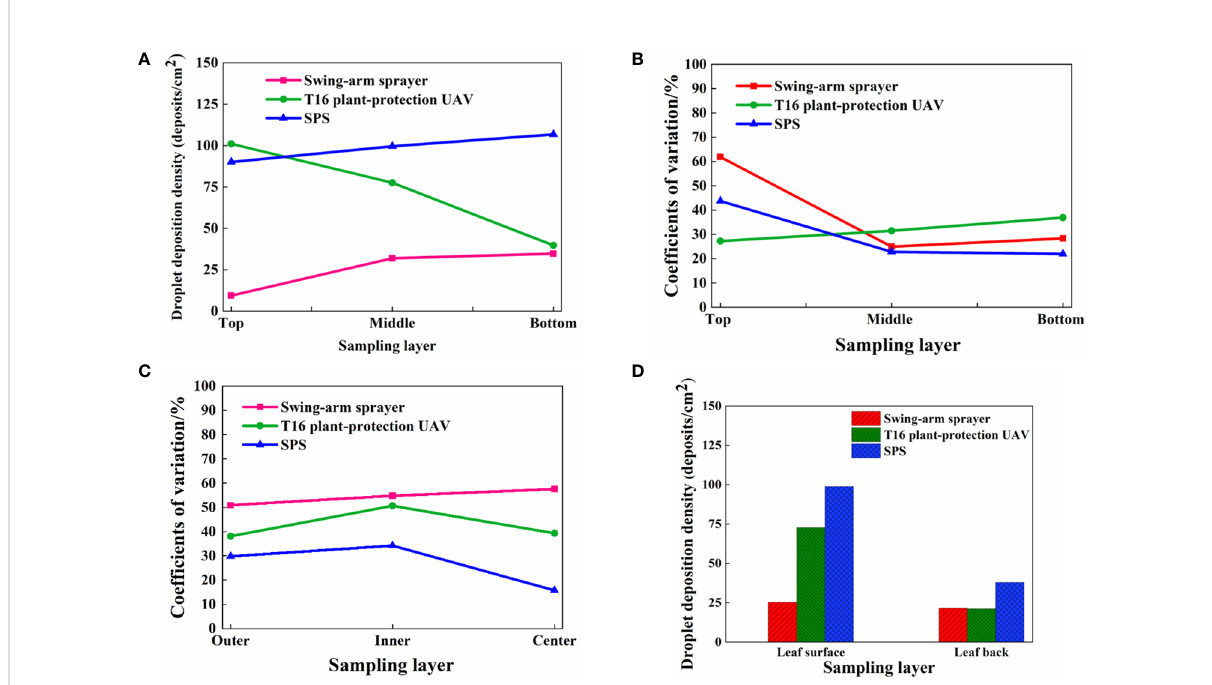
FIGURE 14 Results of the validation experiment of the SPS. (A) Vertical longitudinal sampling layer droplet deposition density. (B) Vertical longitudinal sampling layer droplet distribution uniformity. (C) Horizontal radial sampling layer droplet distribution uniformity. (D) Density of droplet deposition on leaf surface and leaf back. The values in the fi gure are the average values of the sampling points when not stated. For example, the density of droplet deposition in the top of canopies was the means of the values of all the corresponding positions.